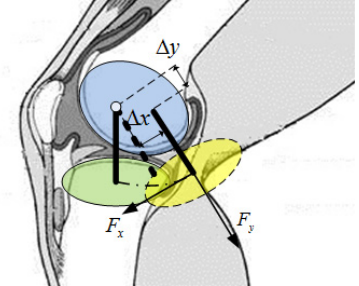
Figure 1. Translations of the lower leg.